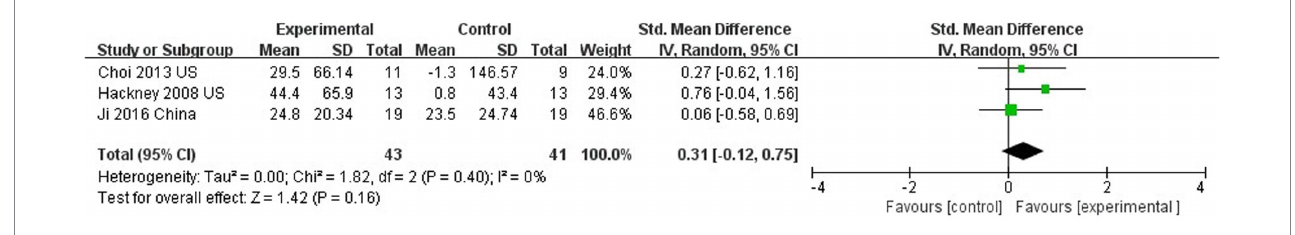
FIGURE 7 The effect of Tai Chi on walking (6MWT).